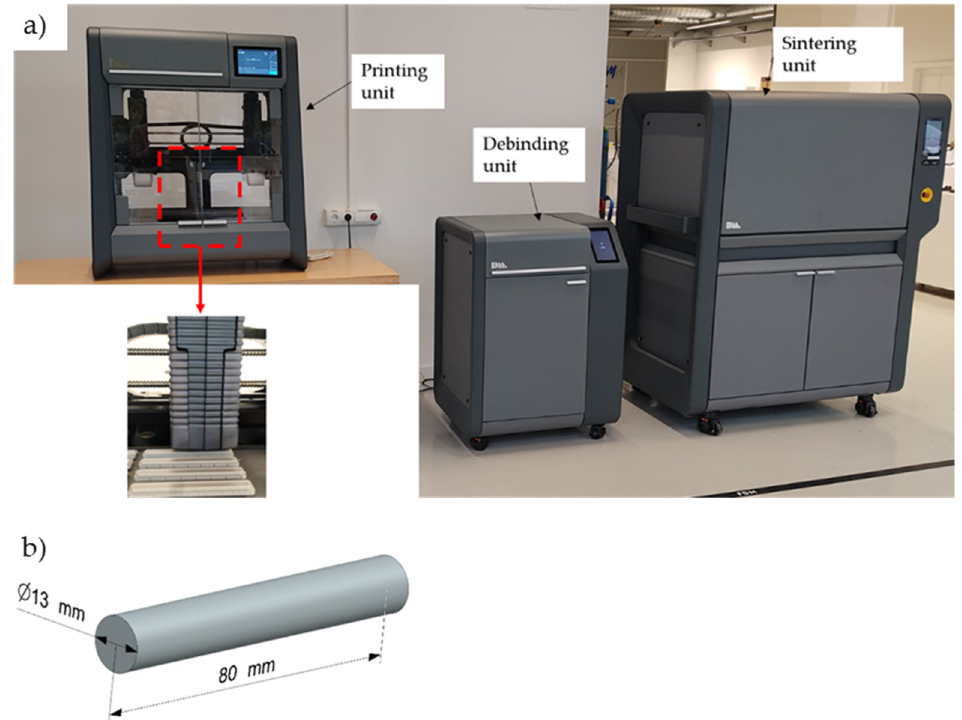
Figure 1. The equipment used in experiments and the cylindrical parts: ( a ) image of the three units of the Studio System TM used for manufacturing of 316L stainless steel cylindrical parts and ( b ) the design (geometry) of the cylindrical parts.